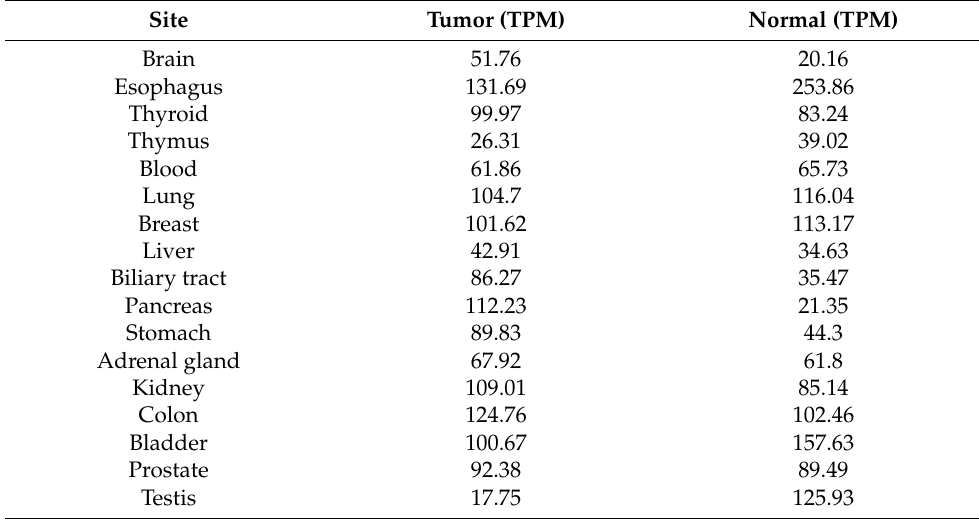
Table 2. The median expression of CAST in different tumor and normal samples.